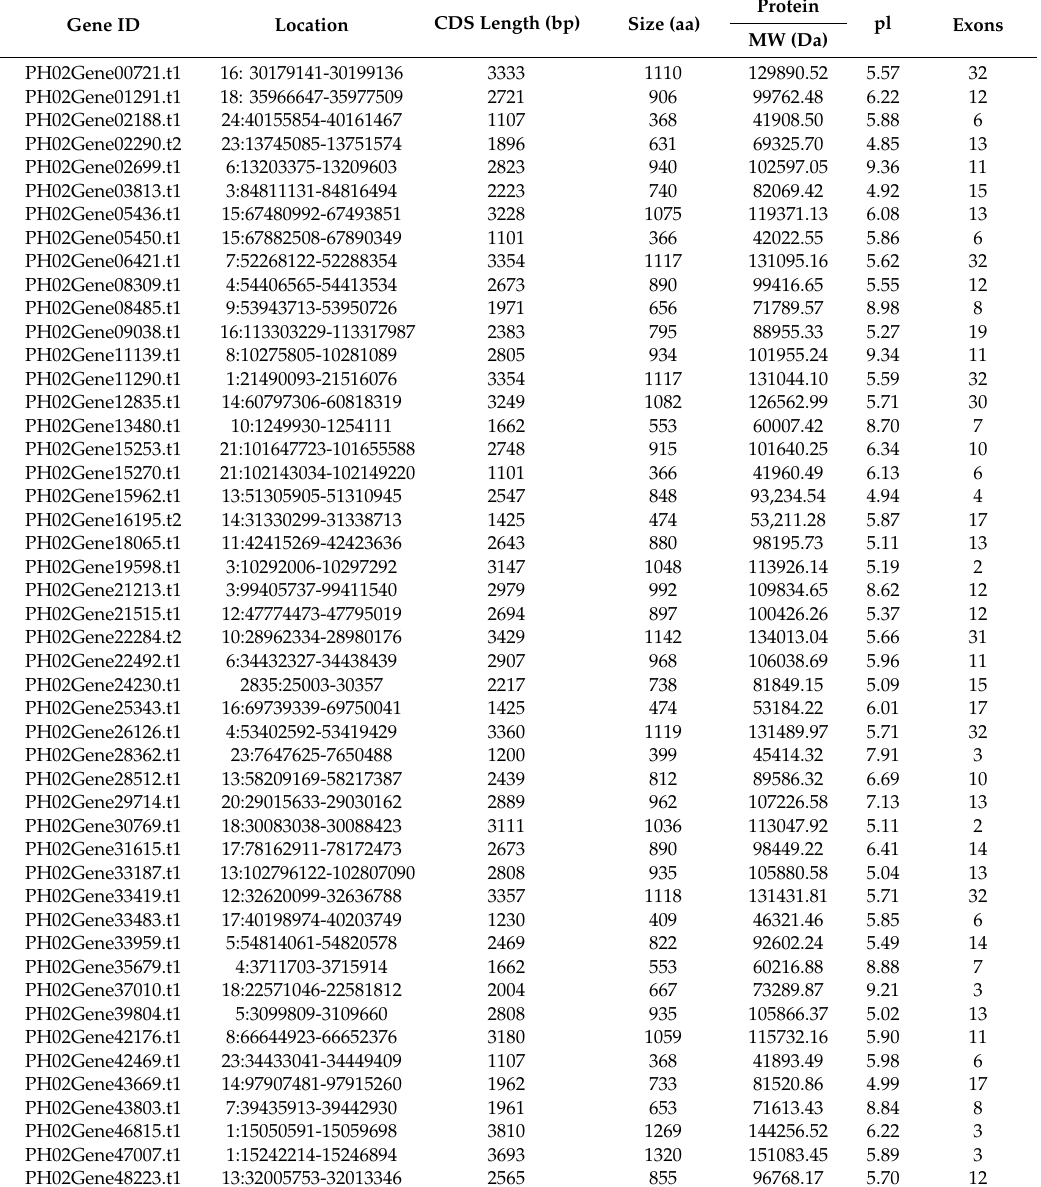
Table 1. Detailed information about 48 predicted PeUBP proteins in moso bamboo. The last column lists the number of exons in each gene. CDS, the coding sequence of a gene; MW, molecular weight; pI, protein isoelectric